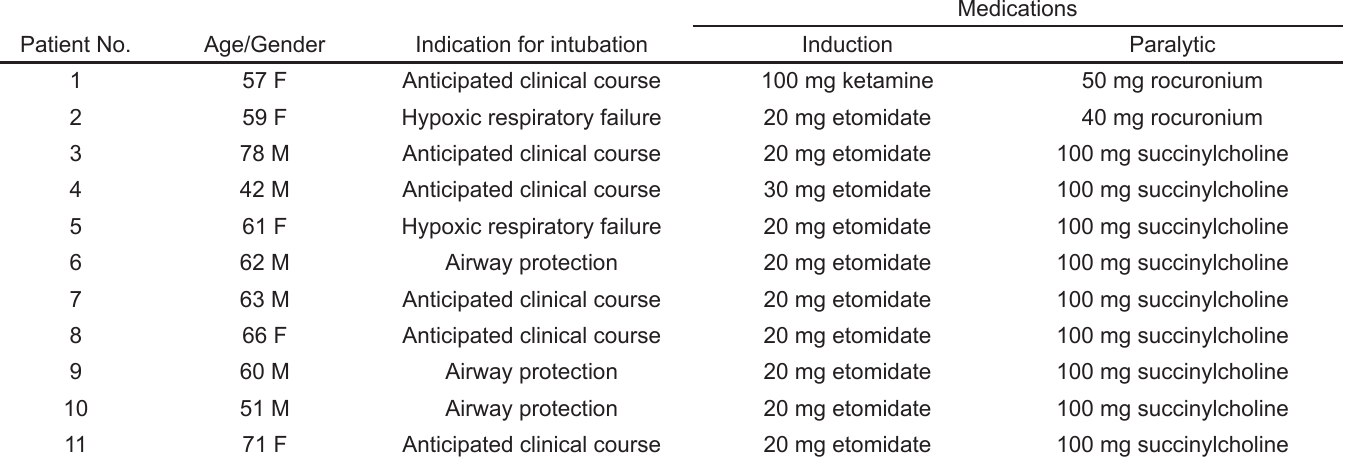
Table 1. General characteristics of patients undergoing rapid sequence intubation. Patient